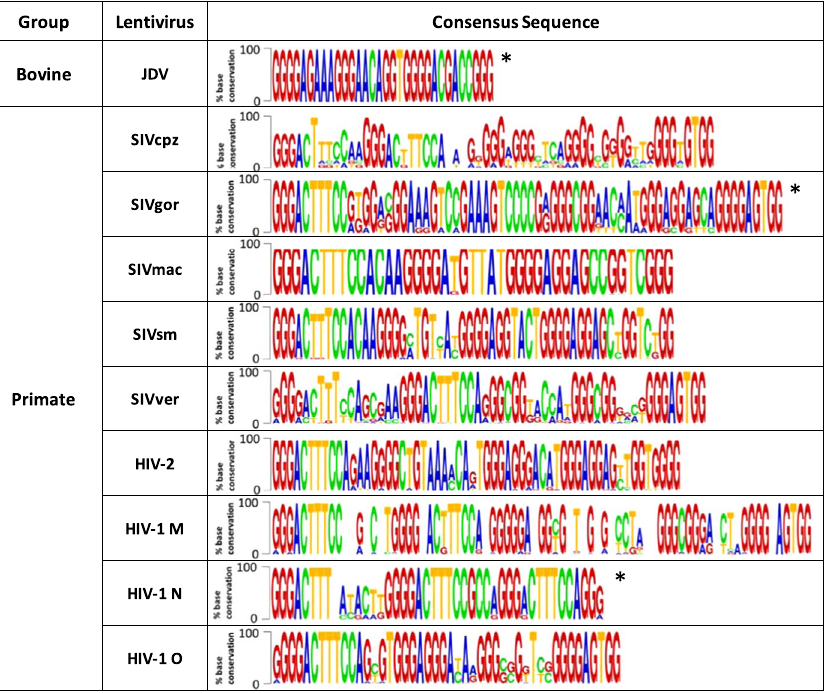
Figure 2. Base conservation of G4 sequences among isolates of lentiviruses. * Consensus sequence obtained by the alignment of 6–10 sequences. All other consensus sequences were obtained by alignment of more than 10 sequences. Lentiviruses with identified PQSs that are not present in this table had lower than 5 complete reported LTR